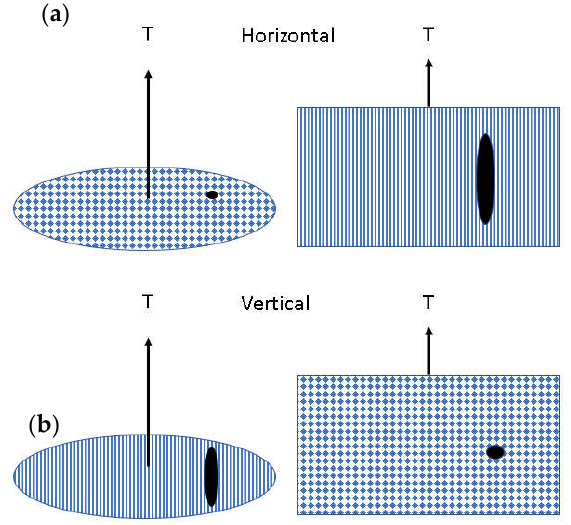
Figure 1. Schematic of LOF/porosity in AM materials. It generally has a high aspect ratio of ellipticity in the ( a ) horizontal direction but low aspect ratio in the ( b ) vertical direction, relative to the built direction.